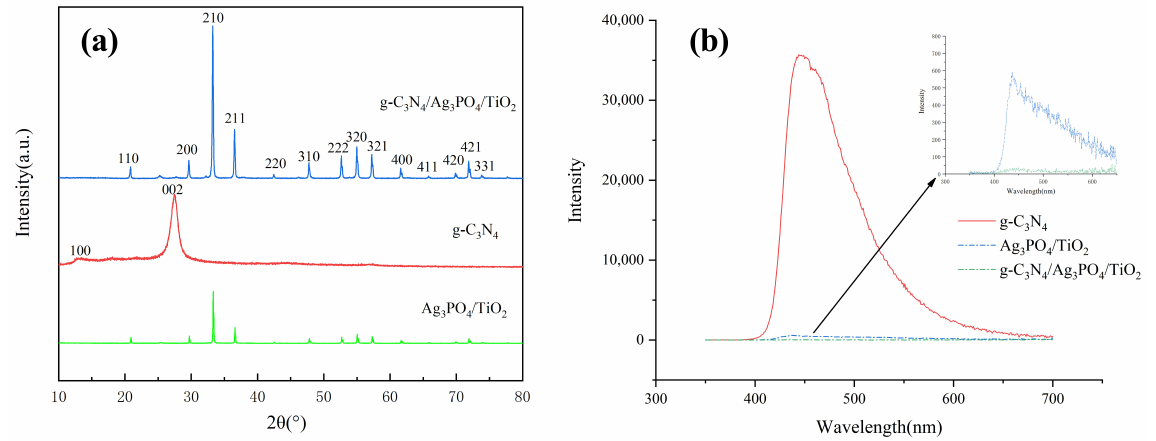
Figure 4. ( a ) XRD patterns and ( b ) PL spectra of g-C 3 N 4 , Ag 3 PO 4 /TiO 2, and g-C 3 N 4 /Ag 3 PO 4 /TiO 2 .